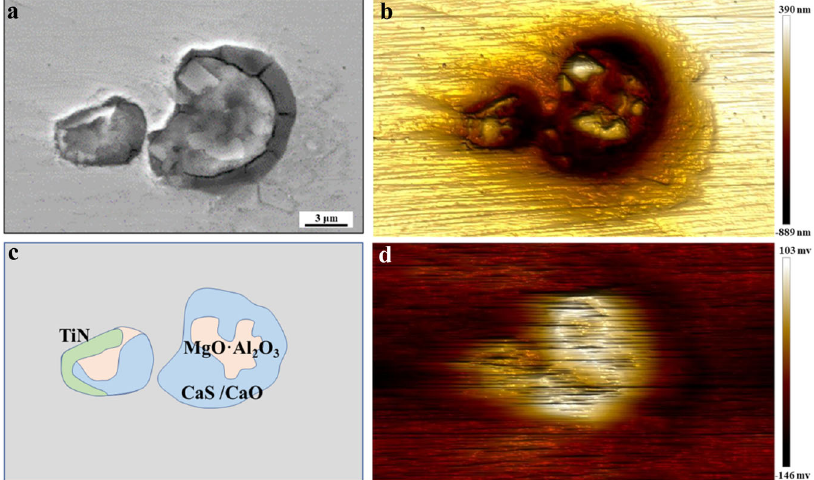
Fig. 11 The morphology and Volta potential of the CaS/CaO-MgO-Al 2 O 3 inclusion. a Dissolution pro fi le; b the surface topography; c substance distribution; and d the surface